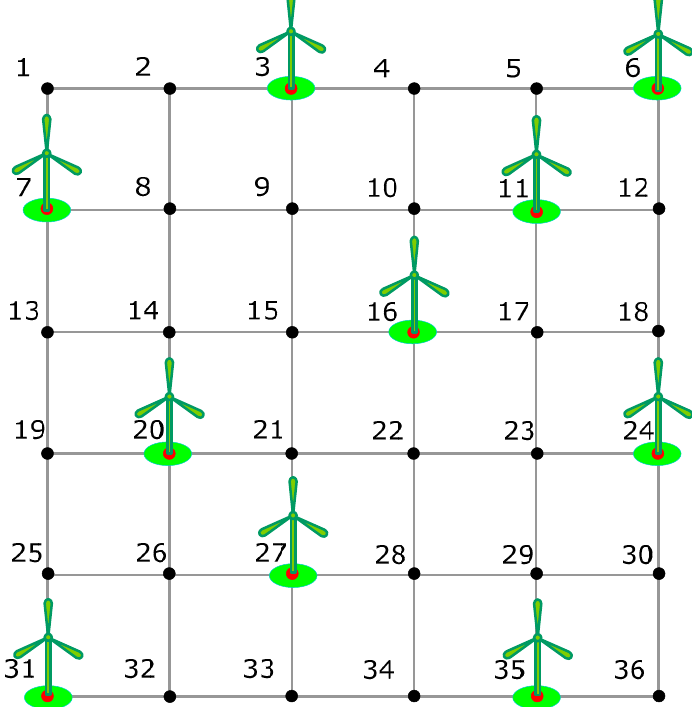
Figure 4. Optimal solution of the wind turbine placement problem considering prohibition at specific locations.